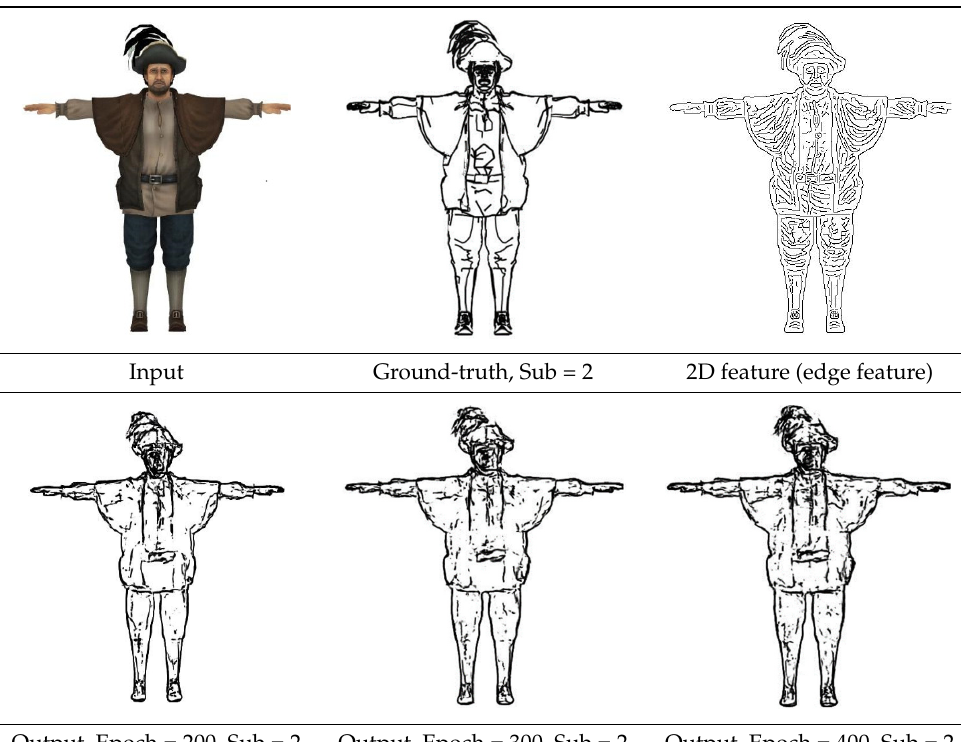
Table 3. Result of the line drawing extraction using a conditional GAN (Example 1).